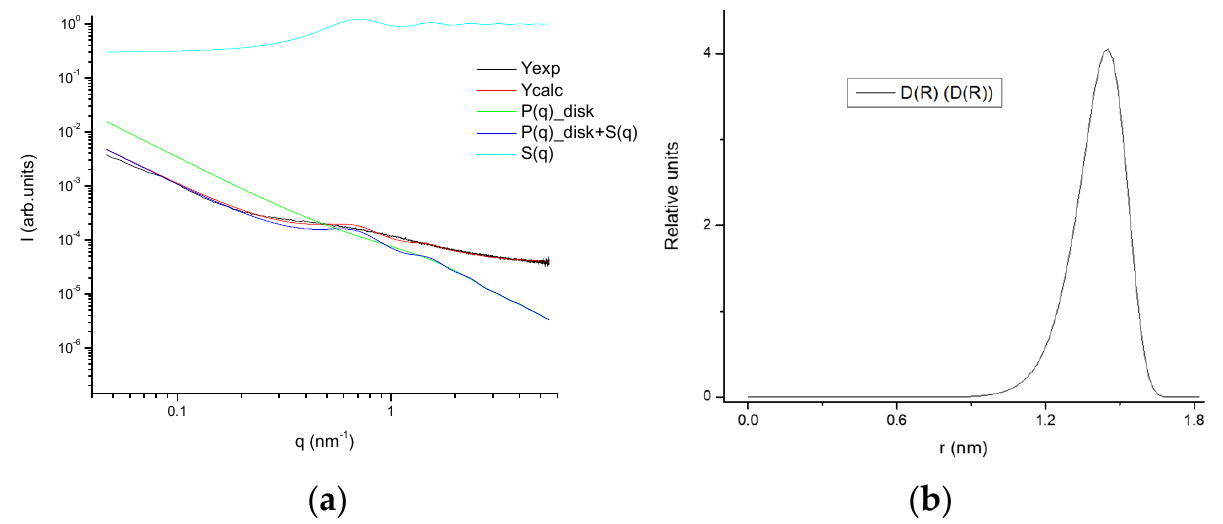
Figure 16. ( a ) Experimental SAXS profile as well as fitted together with the model contributions; ( b ) size distribution of the aggregates of the 25GE hydrogel.